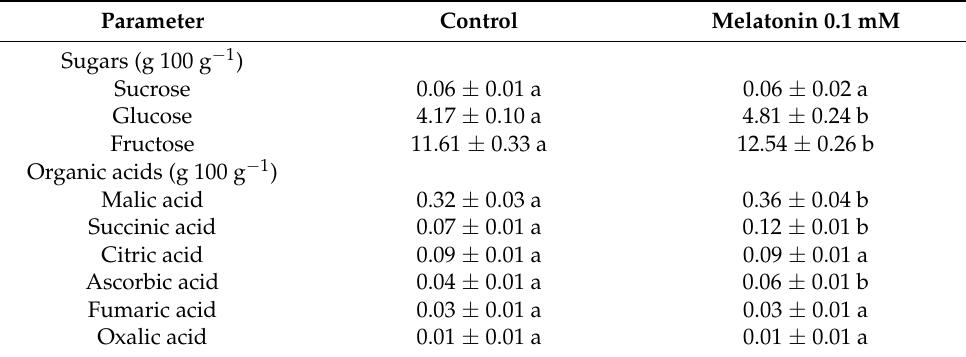
at harvest. Year